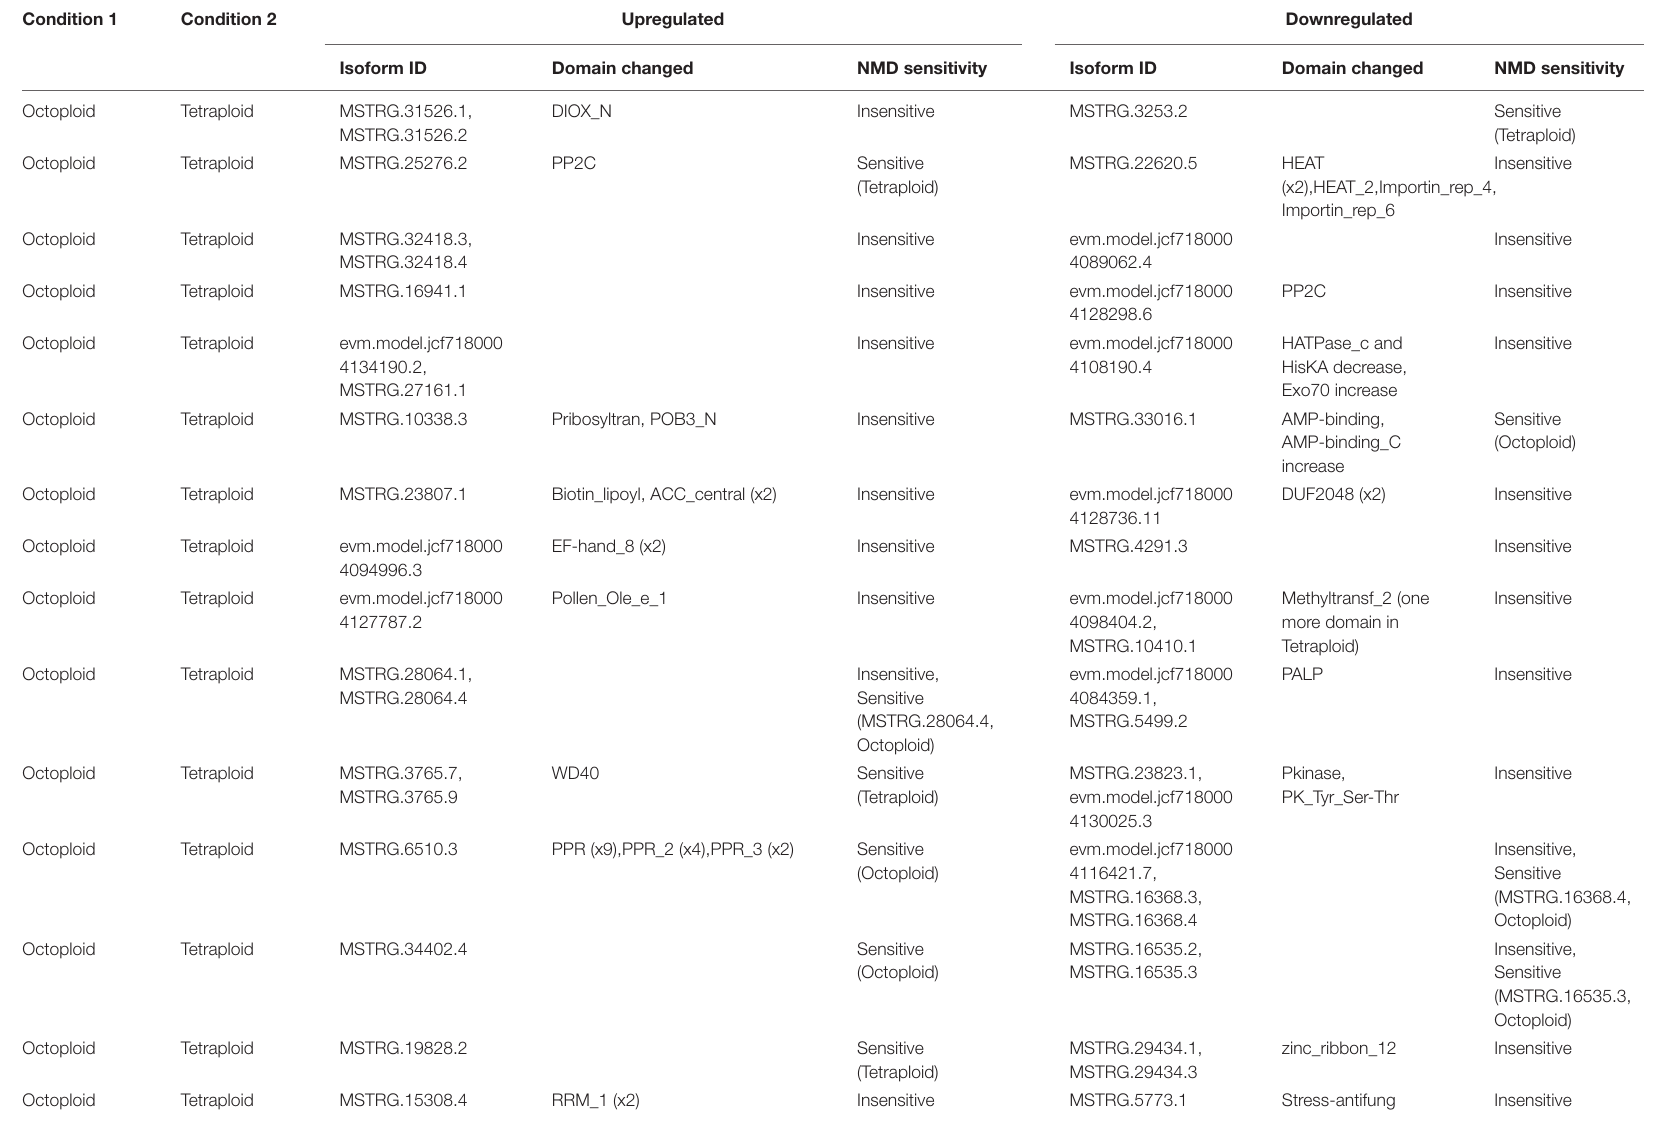
TABLE 4 | Biased isoform switches in differentially expressed